Question: Give a one-sentence summary of this figure.
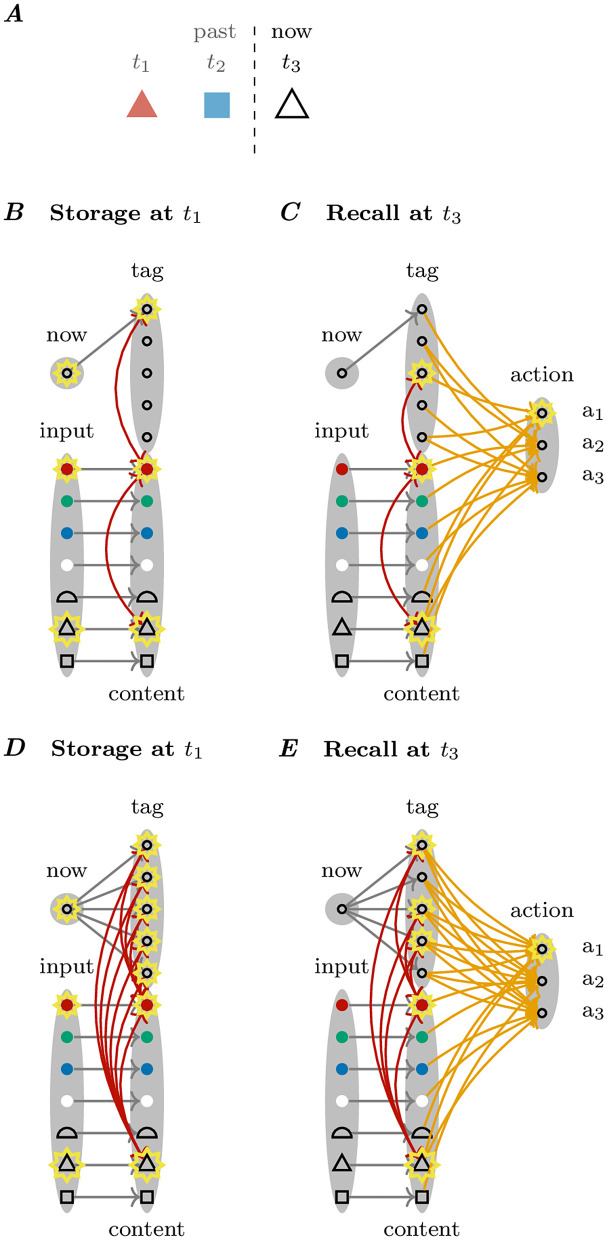
Answer: Age tagging models. A We consider the same sequence of events as in Fig 4A. B In the Onehot-Age-Tagging model, the first tag neuron is activated by the “now” neuron, which is only active during the storage phase, such that Hebbian one-shot learning establishes a connection between the first tag neuron and the active content neurons, when event “red triangle” is perceived at time t 1 . C Thanks to a process that prunes some synapses and grows new ones, tag neuron 3 is activated during recall at time t 3 , indicating how long ago the red triangle was observed. D In the Poprate-Age-Tagging model, connections to all tag neurons are formed during storage. E These connections are pruned at different moments in time, such that during recall at time t 3 , fewer connections are present than at time t 1 . The number of active “tag” neurons during recall encodes the elapsed time since storage: if many “tag” neurons are active during recall, the recalled event happened recently and if few “tag” neurons are active, it happened long ago.